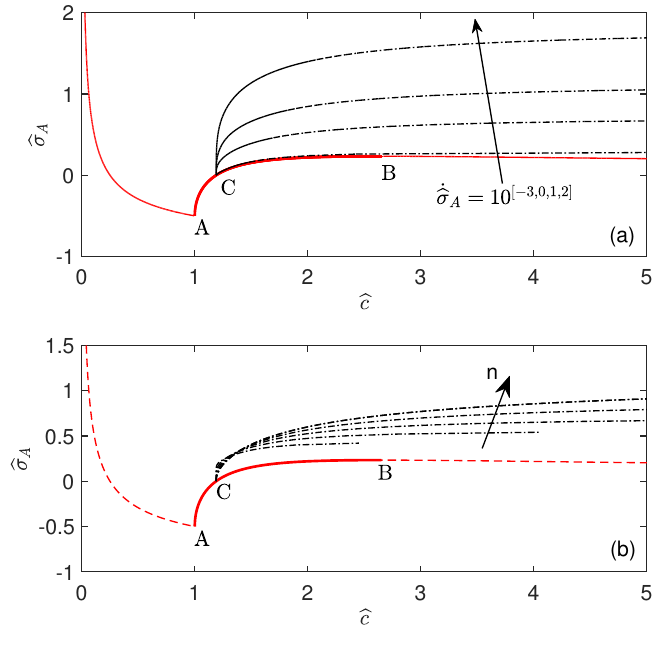
Figure 5. ( a ) Unloading curves of the dimpled surface starting from (cid:98) σ A = 0 for α d = 0.5, n = 0.5 · [ − 3,0,1,2 ] . Red lines for the Griffith elastic solution, dot-dashed black lines for the a and (cid:98) σ A = 10 rate-dependent unloading curves. ( b ) As panel ( a ) but for